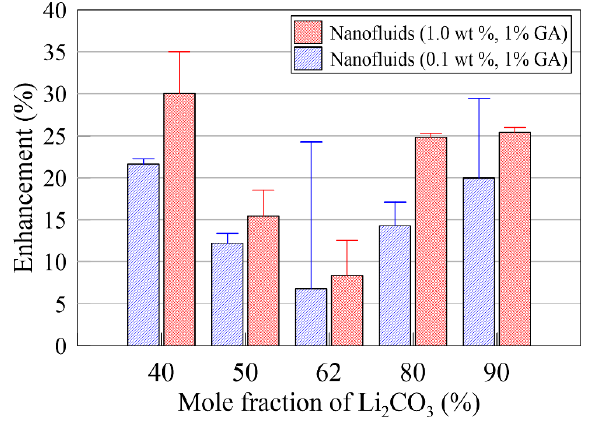
Figure 5. Enhancements of the specific heat for five different chemical compositions of base fluid.